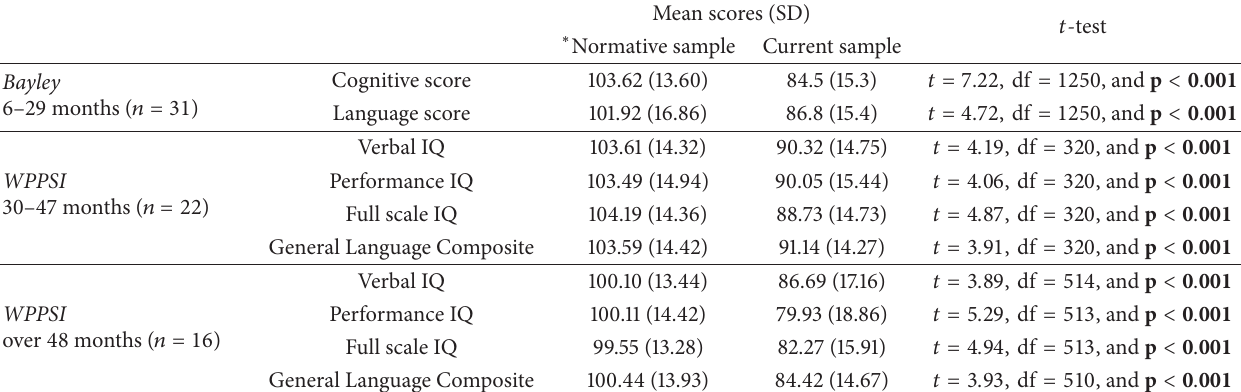
Table 2: Comparison of our sample to normative samples on measures of cognition and language.